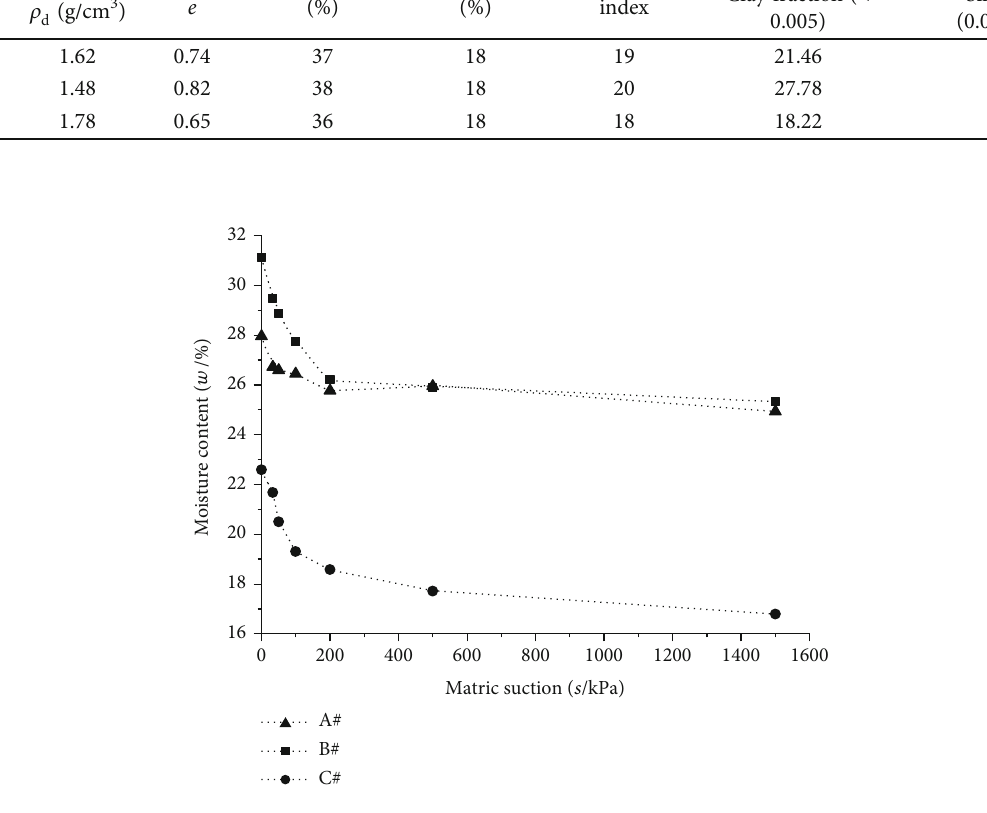
Figure 3: SWCC of three kinds of soil with di ff erent gradations. Table 2: Characteristic parameter of SWCC.